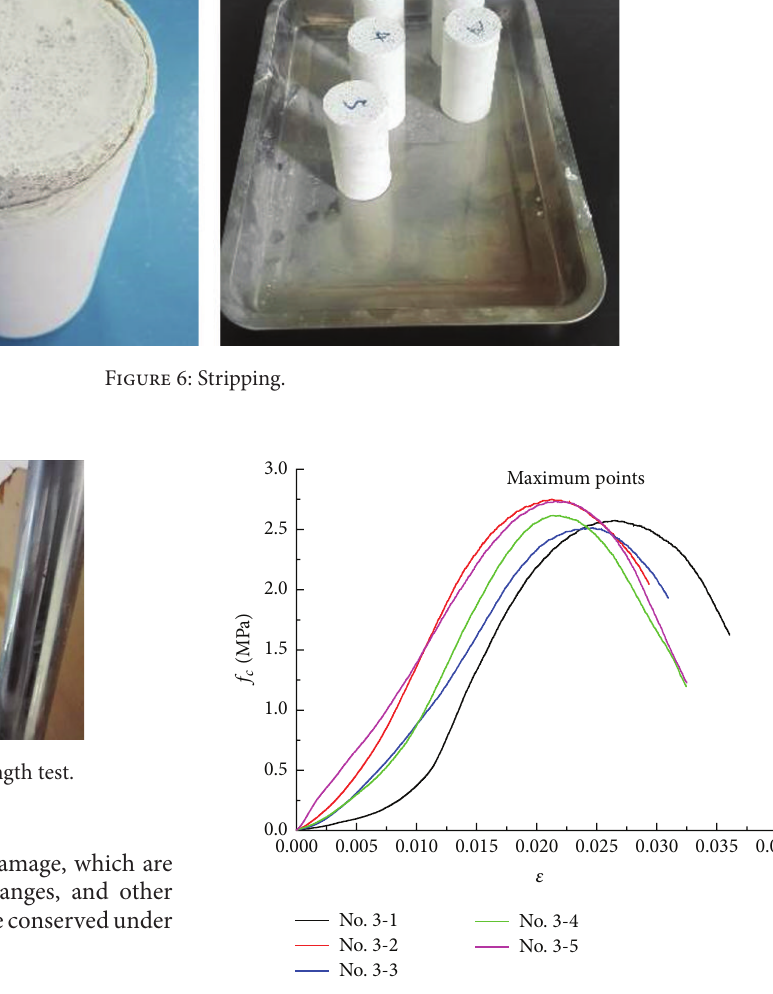
Figure 8: Uniaxial compressive stress-strain plots: Group 3.